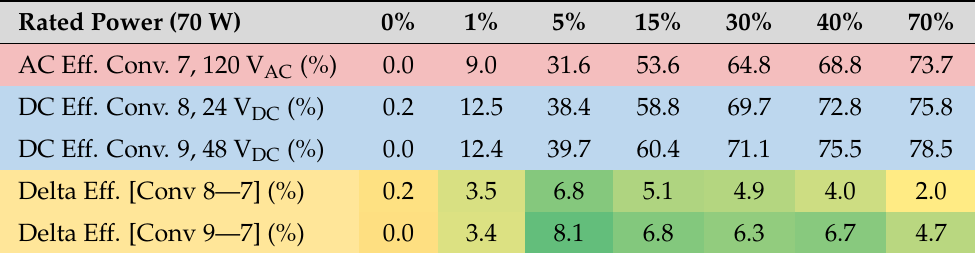
Table 6. Delta Efficiency (DC-AC) for SIMO test converters rated at 70 W.